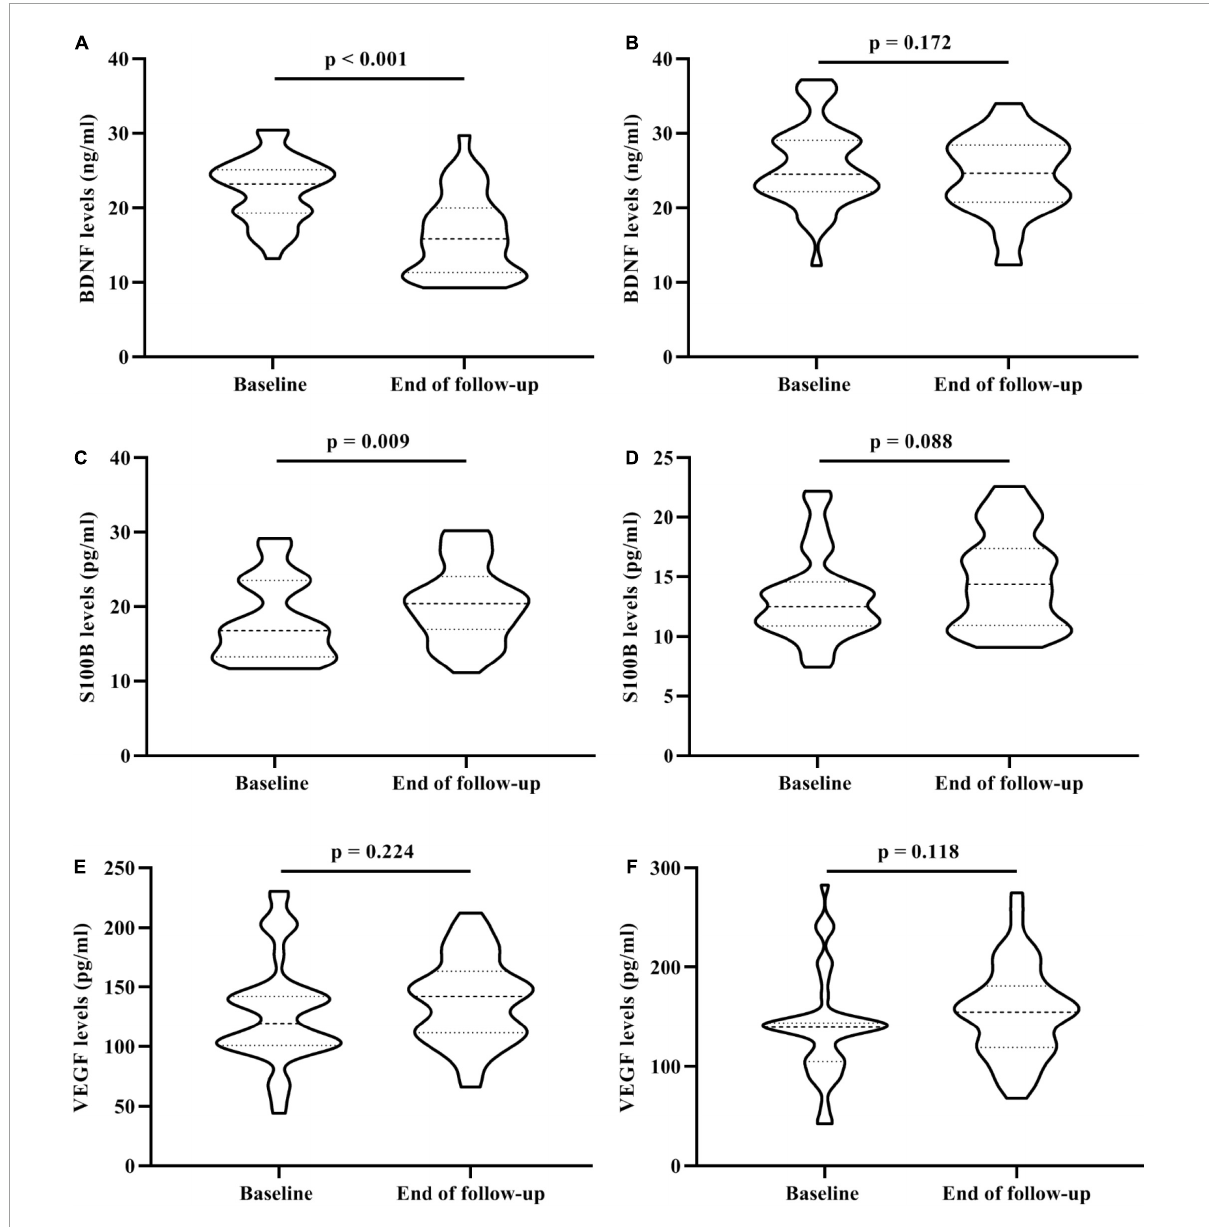
FIGURE2 The change of serum BDNF, VEGF, and S100B levels in 81 OA participants who underwent the 3-year follow-up. (A) The change of serum BDNF levels between baseline and the end of follow-up in trans-MDD group. (B) The change of serum BDNF levels between baseline and the end of follow-up in non-MDD group. (C) The change of serum S100B levels between baseline and the end of follow-up in trans-MDD group. (D) The change of serum S100B levels between baseline and the end of follow-up in non-MDD group. (E) The change of serum VEGF levels between baseline and the end of follow-up in trans-MDD group. (F) The change of serum VEGF levels between baseline and the end of follow-up in non-MDD group. BDNF, brain-derived neurotrophic factor; VEGF, vascular endothelial growth factor; OA, osteoarthritis; MDD, major depressive